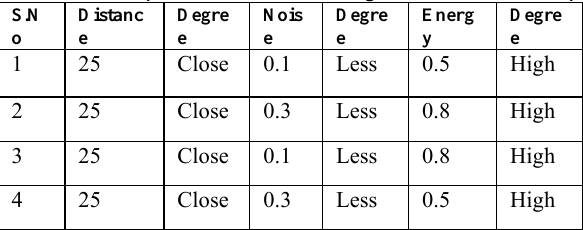
Table 11. Output table with the degree of membership S.N